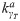
Global perfect homeostasis is limited by dilution and basal degradation.(A) Schematic of a system where transporter degradation occurs by two mechanisms: (1) activity-dependent downregulation (rate constant of kγTa) and (2) dilution and basal degradation (rate constant kγTc). (B) Robustness, r, of the system from (A) given different ratios of kγTa to kγTc. The blue and magenta cross-sections correspond to the blue and magenta curves in (C). (C) In the limit where kγTa goes to zero, Sint tracks Sext (orange). In the limit where kγTc goes to zero, the Sint is independent of the Sext (black). (D) Transporter levels as a function of Sext for the same four ratios of kγTa to kγTc as in (C). As kγTakγTc→∞, T changes inversely with Sext which allows the system to achieve homeostasis.